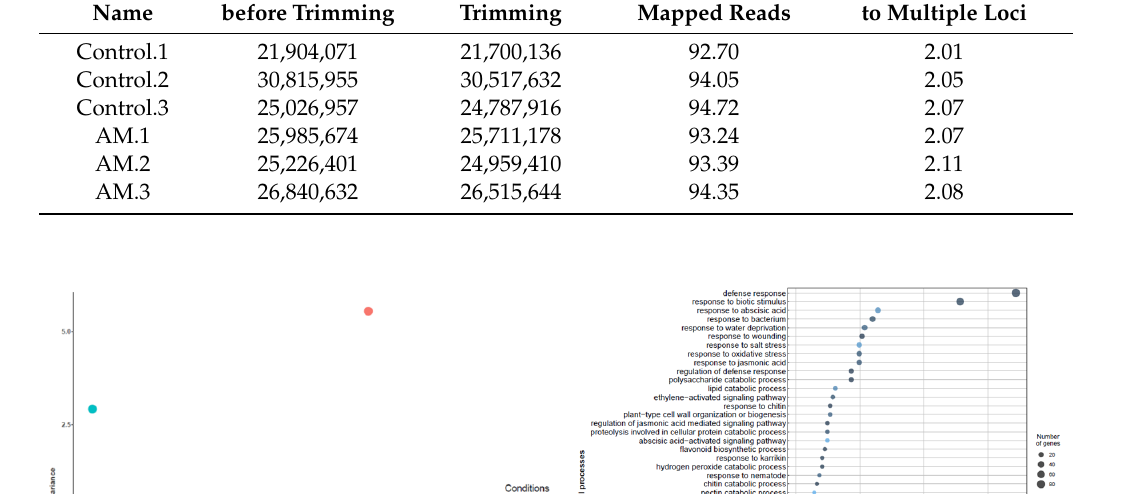
Table 1. Information on the mapping of RNA sequencing reads on the genome of P. sativum cv. Cam é or. Sample